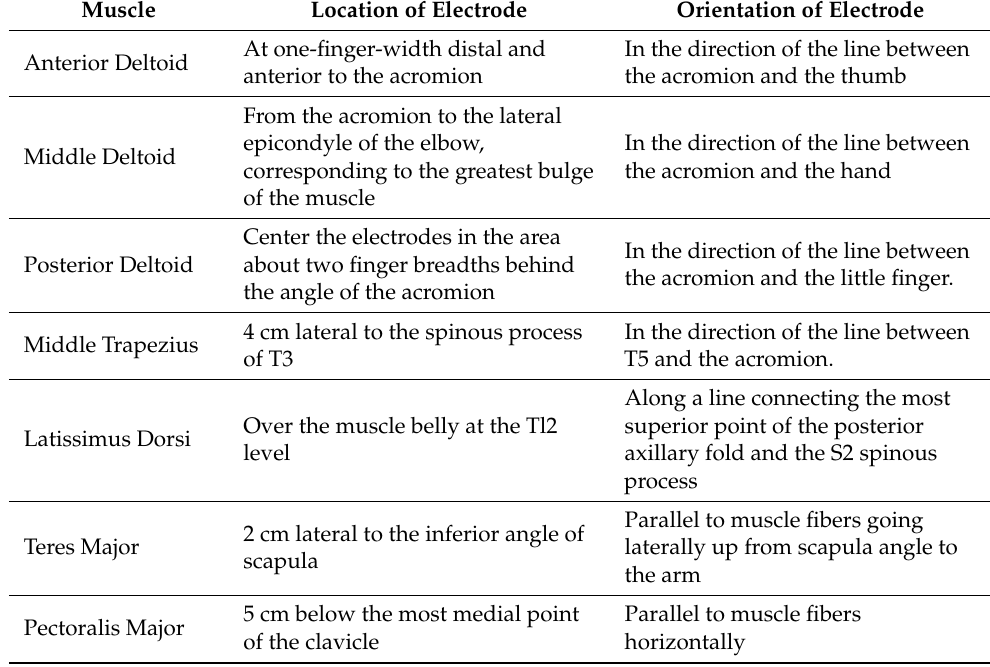
Table 2. Electrode